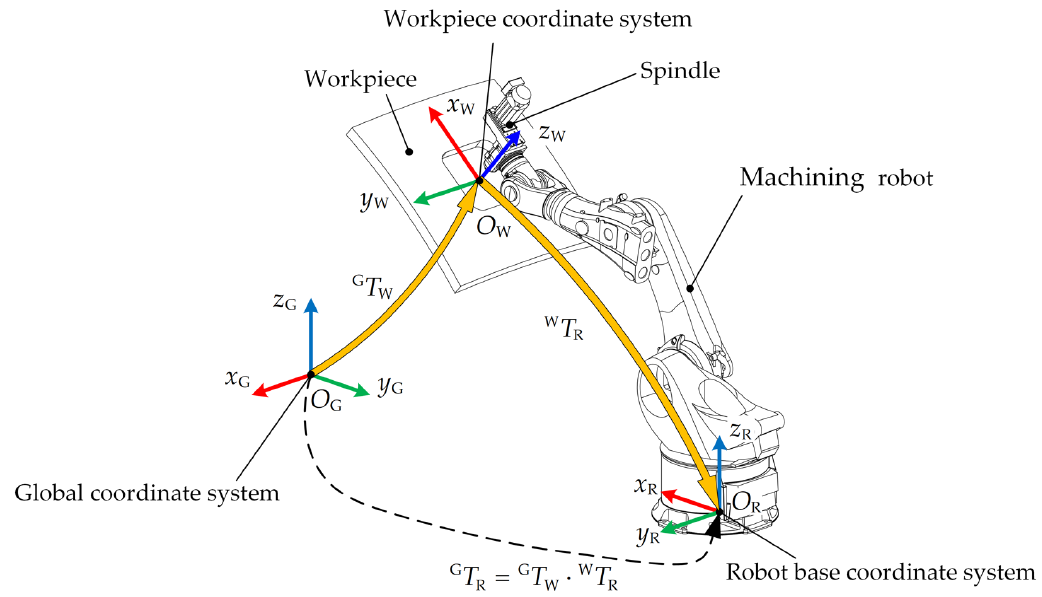
Figure 1. Placement planning model of the flexible machining system. The homogeneous transformation matrix G